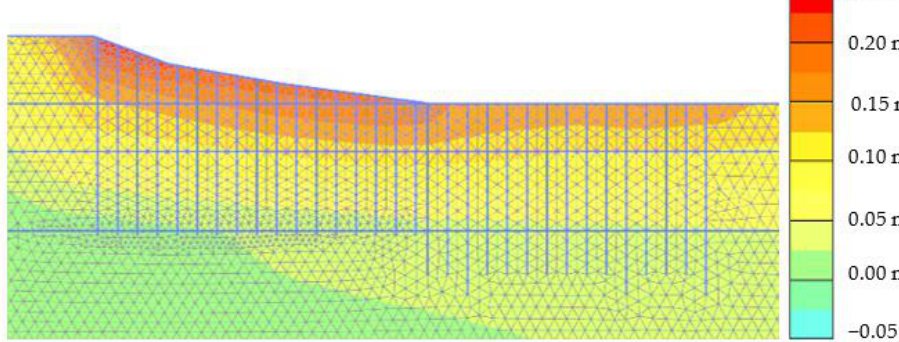
Figure 12. FEA of the ME waveform: Residual displacement.